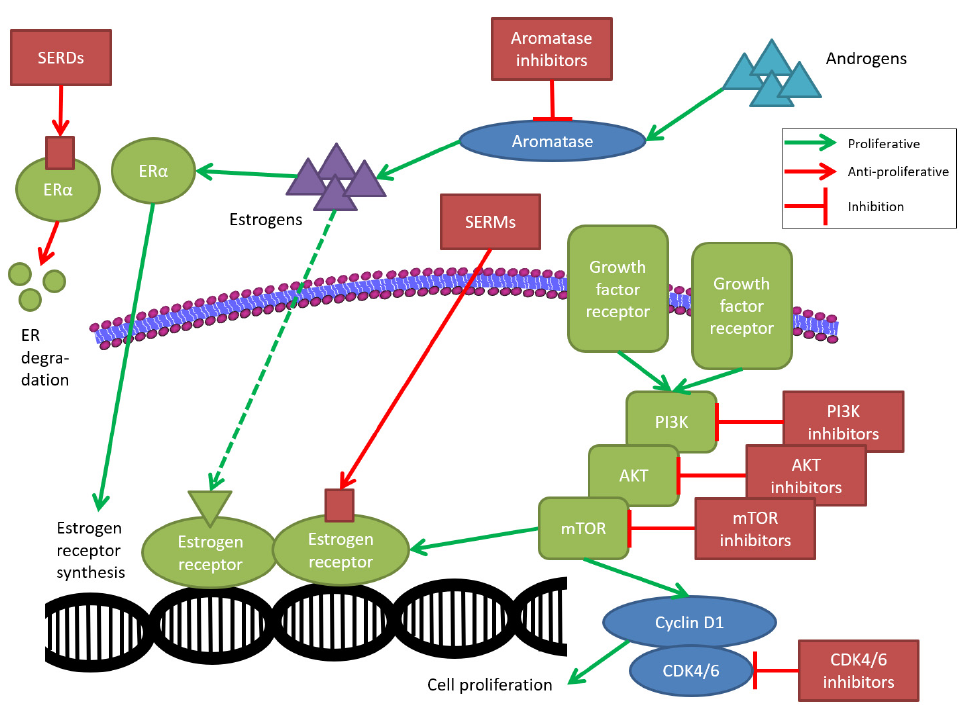
Figure 1. Therapeutic mechanisms of endocrine therapy (simplified representation) [16,17]. AKT: AKT murine thymoma viral oncogene; ER(alpha): estrogen receptor (alpha); CDK4/6: cyclin-dependent kinase 4/6; mTOR: mammalian target of rapamycin; PI3K: phosphatidylinositol 3-kinase; SERD: selective estrogen receptor degrader; SERM: selective estrogen receptor